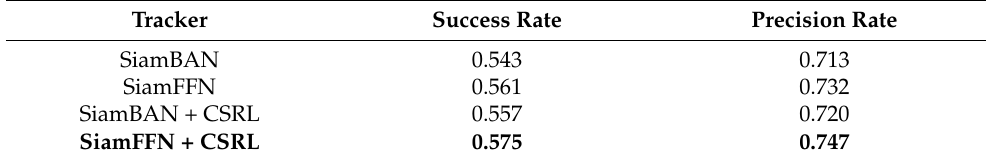
Table 3. Ablation study on UAV20L. Tracker Success Rate Precision Rate SiamBAN